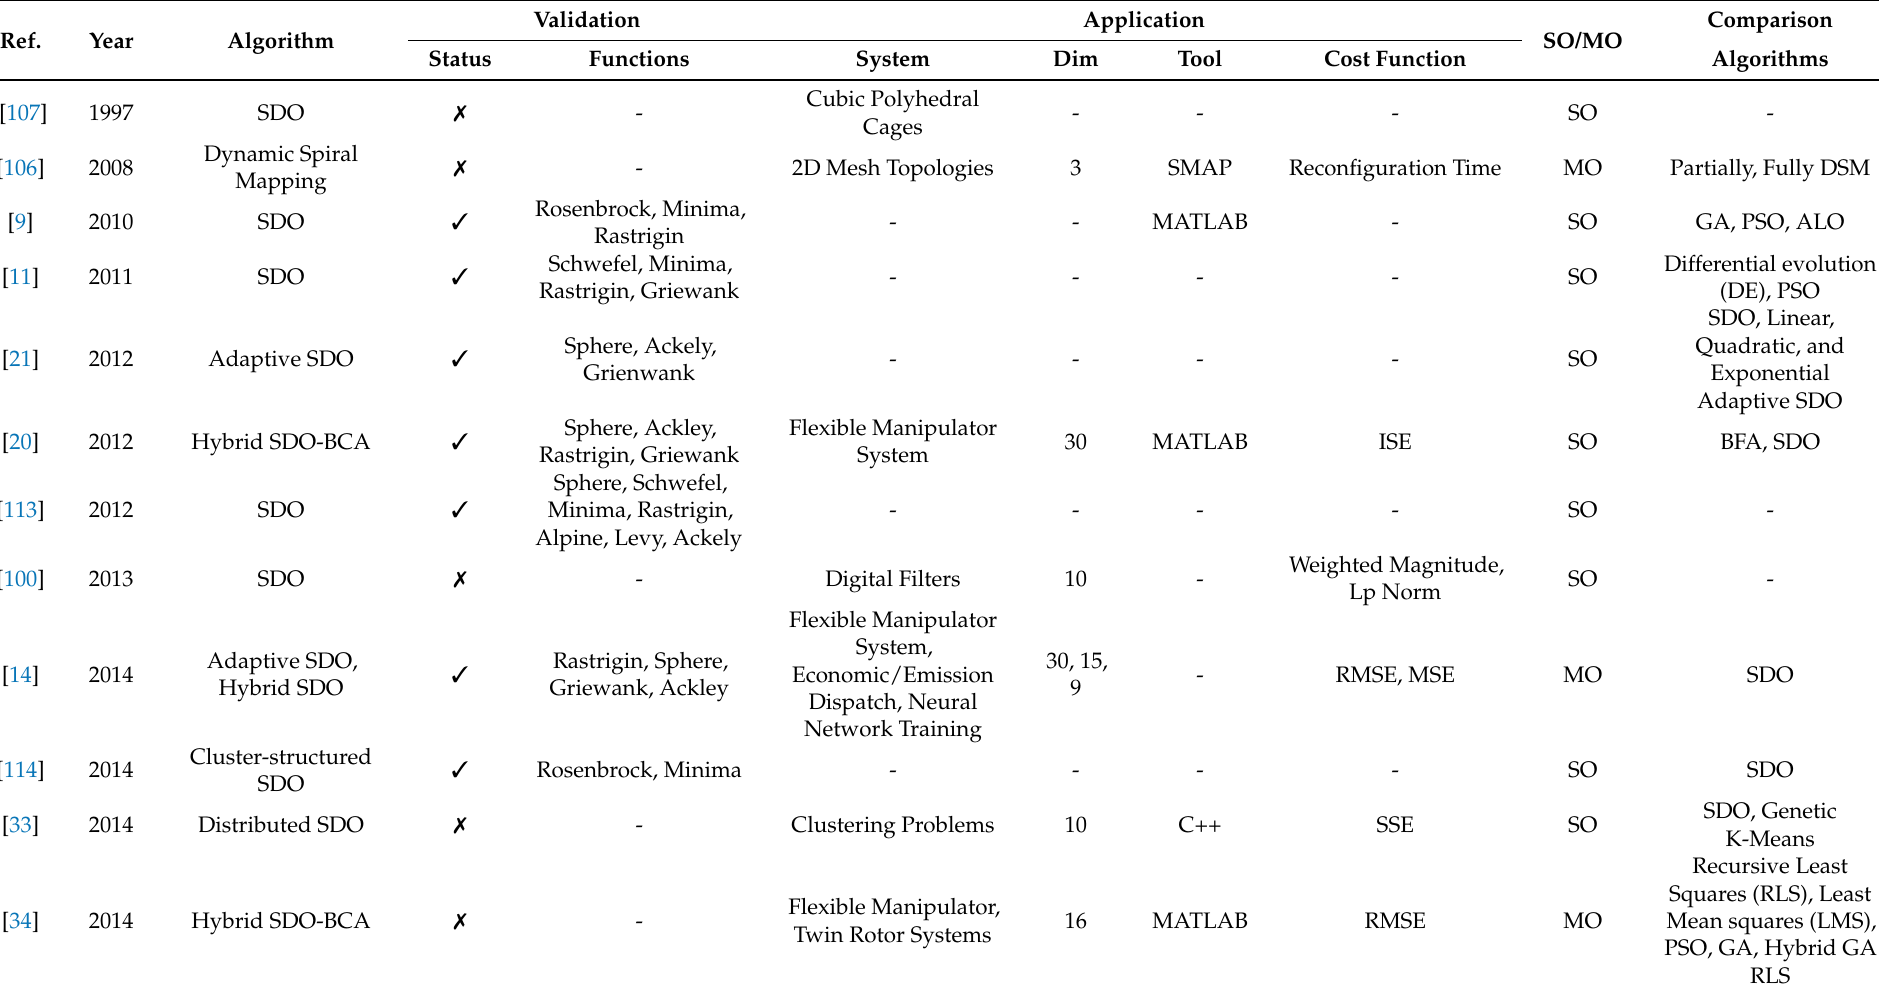
Table 2. List of applications of SDO and its variants in various fields over the years.